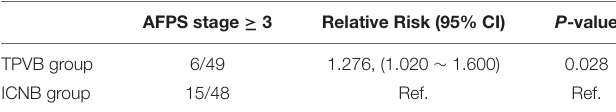
TABLE 2 | Comparison of Aono’s four-point scale between the two groups.